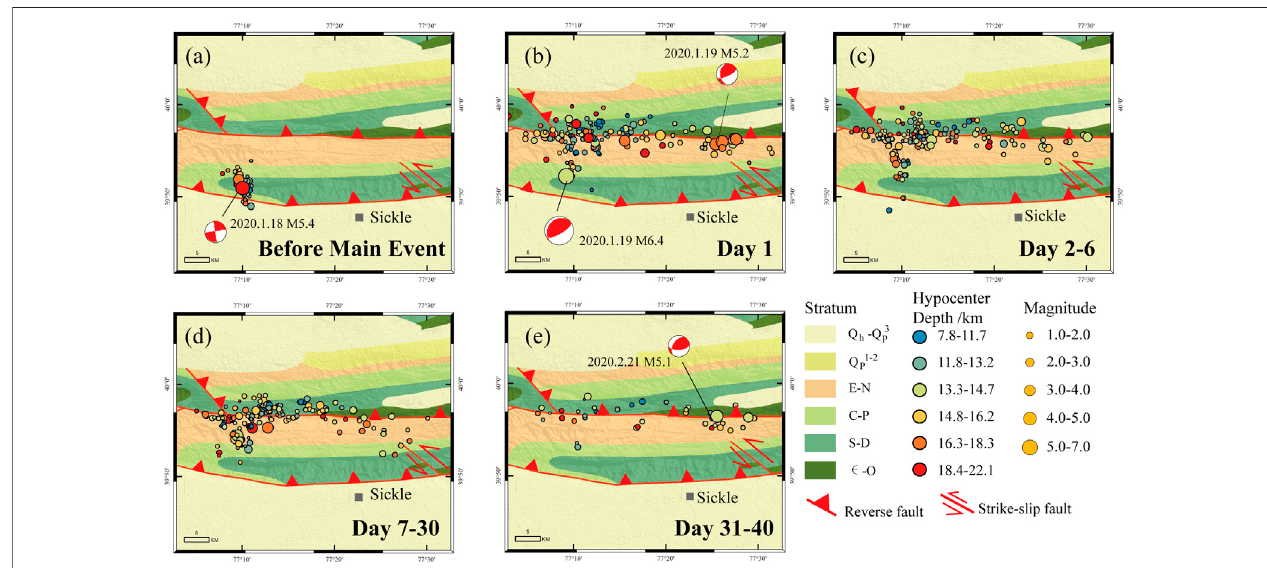
FIGURE 5 | Spatiotemporal evolution of the 2020 Jiashi earthquake sequence. The size and color of circles represent the magnitude and hypocentral depth, respectively. The thick red lines indicate the surface traces of faults. The FMSs were obtained from the CENC.